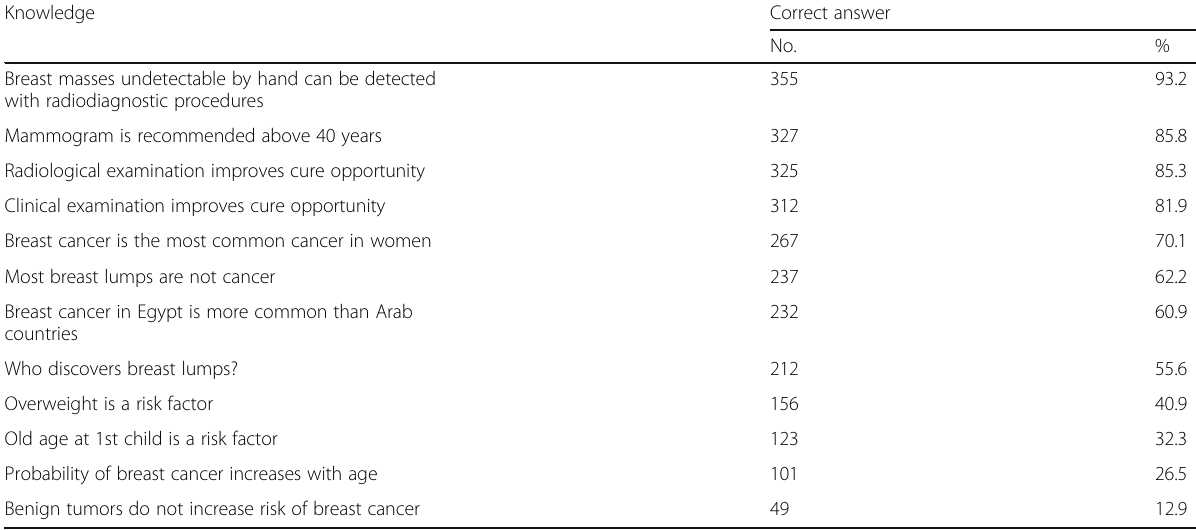
Table 2 Knowledge about breast cancer risk factors and methods of its screening